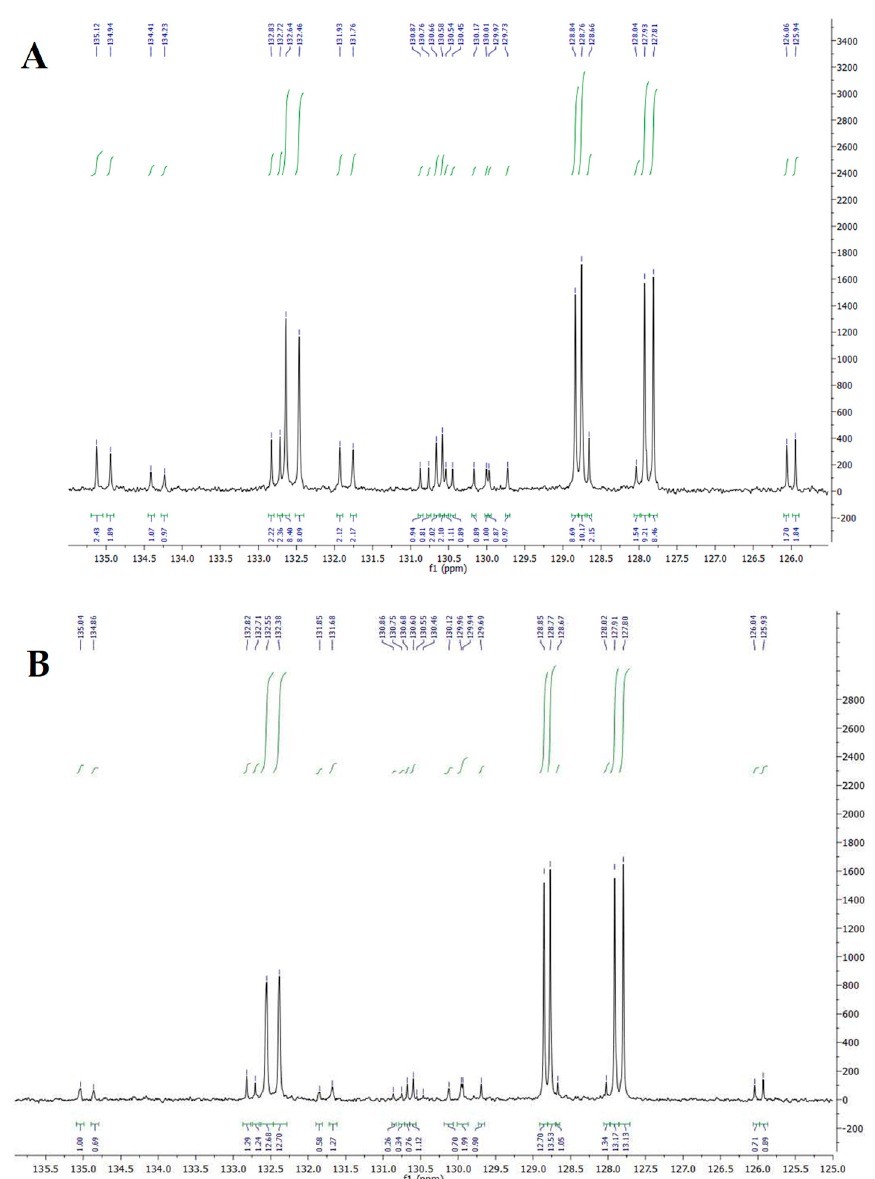
Figure 2. 13 C NMR diagnostic olefinic region related to transesterified Soxhlet oil, 1a , (Panel A), transesterified scCO 2 oil, 2a (Panel B).